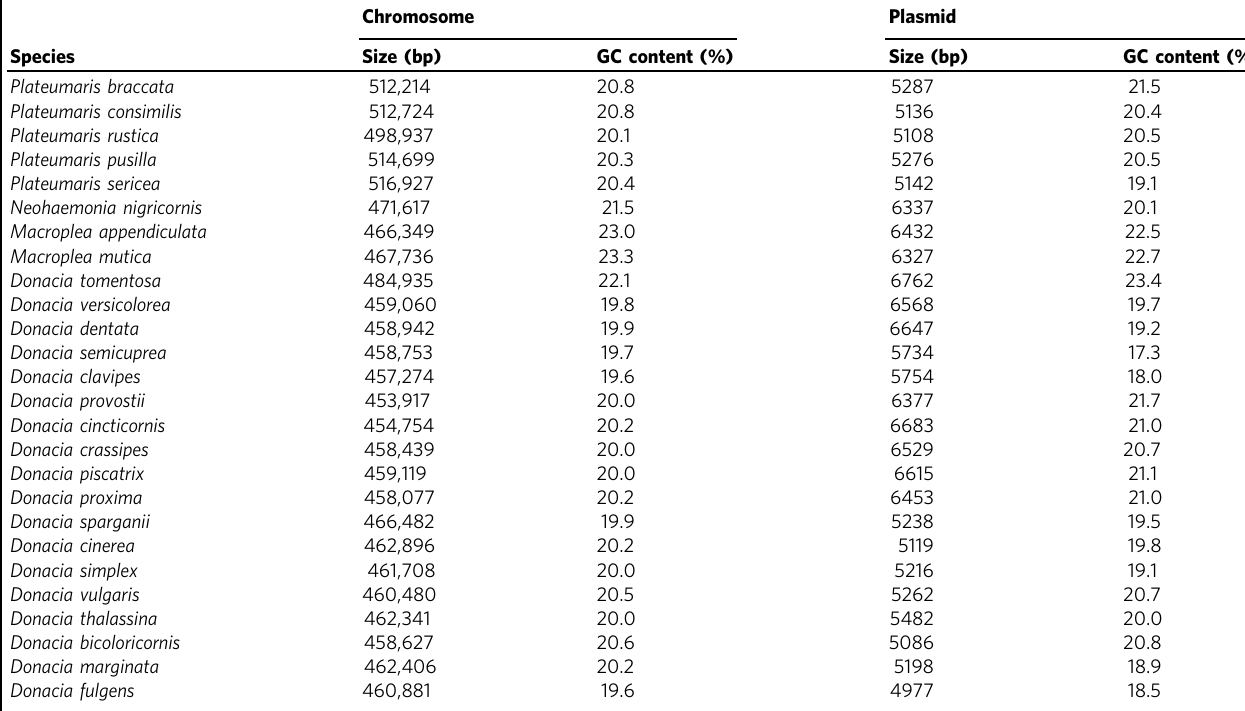
Table 1 Characteristics of symbiont genomes across 26 Donaciinae host species in four